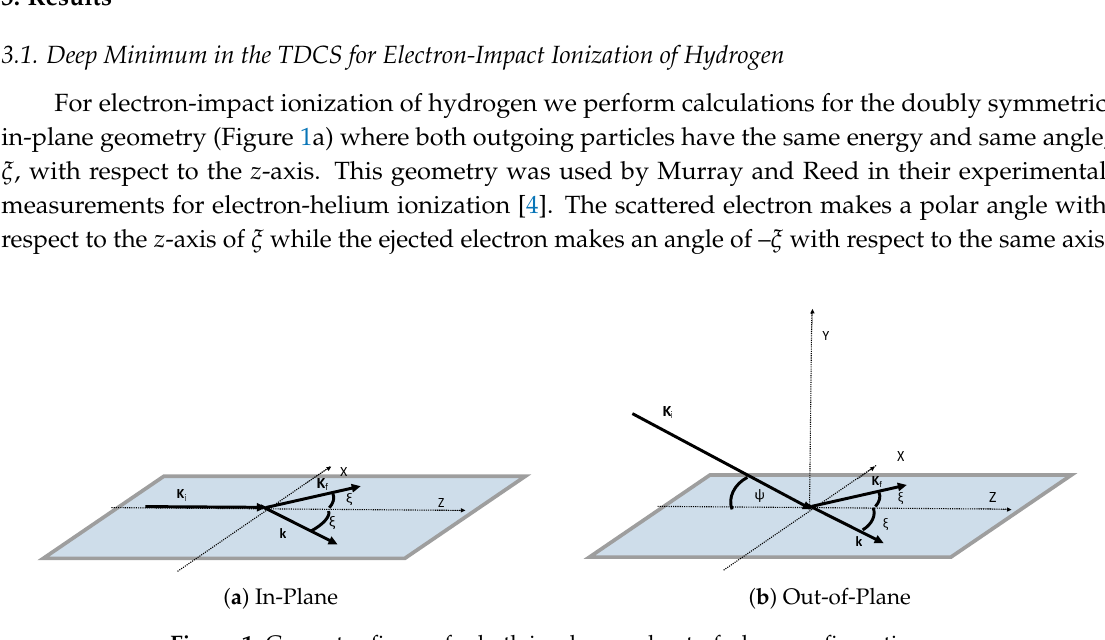
Figure 1. Geometry figures for both in-plane and out-of-plane